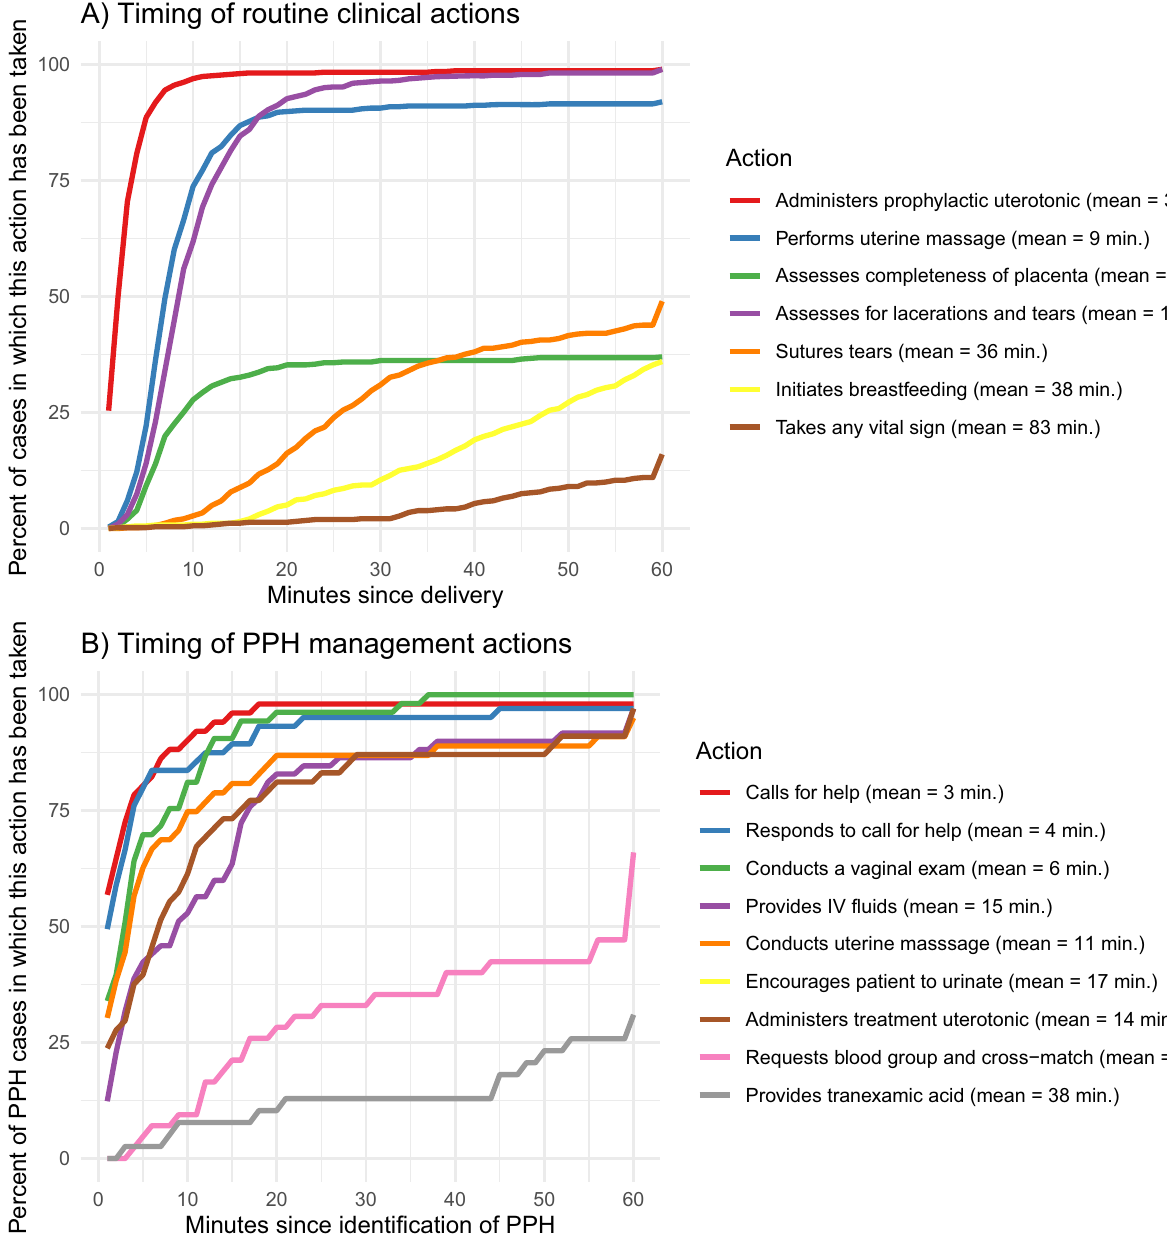
Fig 3. Timeliness of routine care and PPH management. Notes: This figure shows the cumulative distribution of the completion of different clinical actions over time. Panel A shows the timing of routine actions, measured in minutes since the delivery of the final newborn. Panel B shows the timing of actions